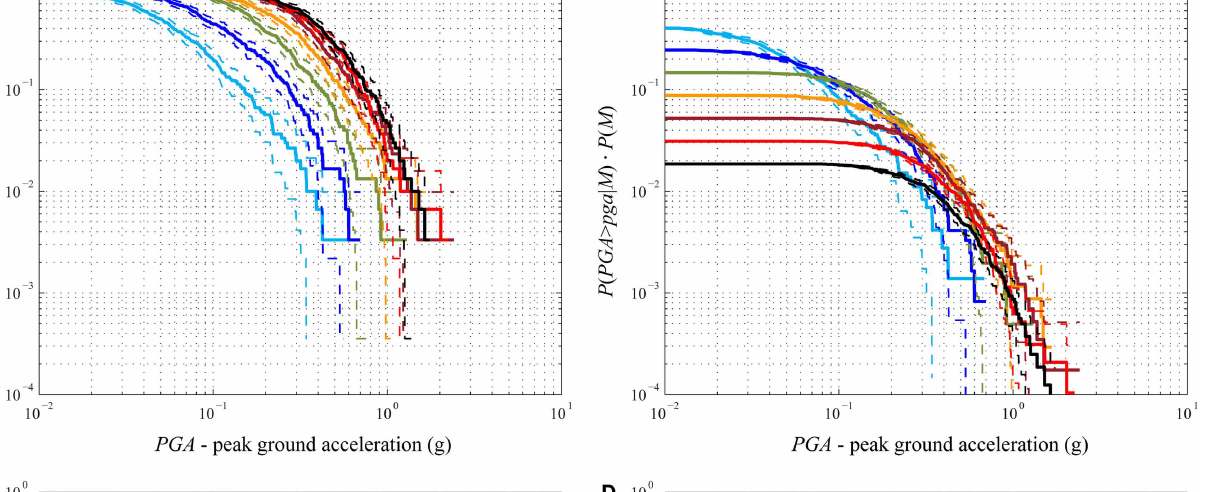
FIGURE 10 | (A) Conditional hazard curve for PGA. (B) Weighted conditional hazard curves for PGA. (C) Conditional hazard curve for S a ( T = 0.3s). (D) Weighted conditional hazard curves for S a ( T = 0.3s). (E) Conditional hazard curve for S a ( T = 3s). (F) Weighted conditional hazard curves for S a ( T = 3s).